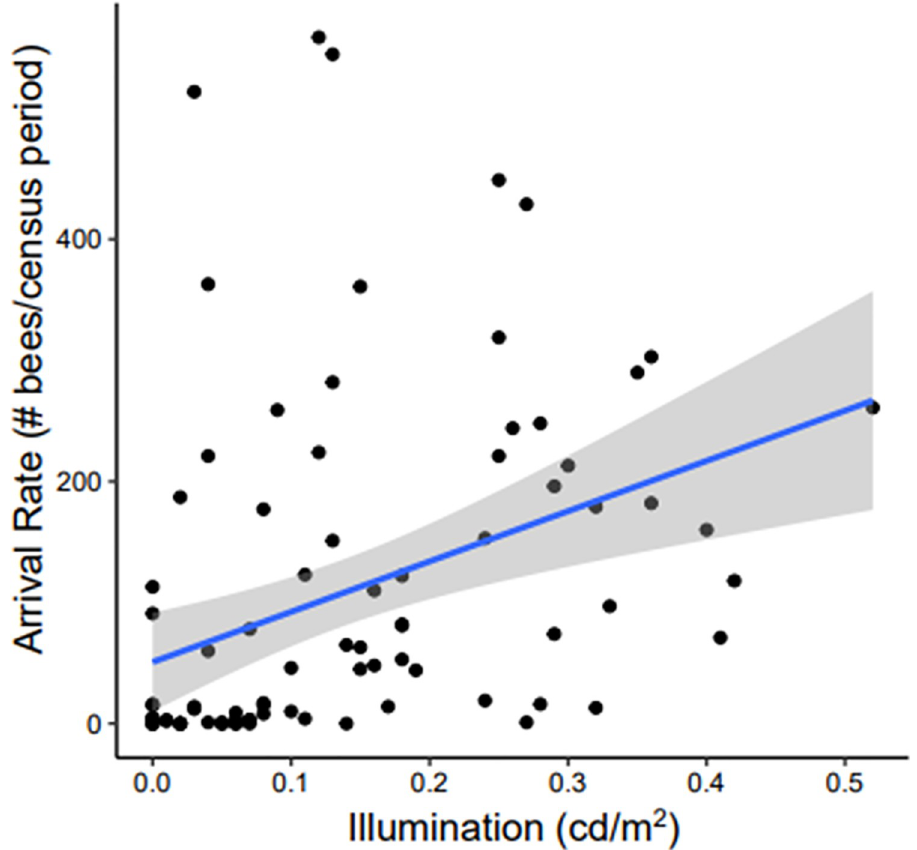
Fig 4. Relationship between nighttime illumination and bee arrival rates. A regression between environmental illumination at night and number of bee arrivals to the nest per census period is shown. Illumination had a significant positive effect on arrivals, such that as illumination increased arrivals also increased ( r were seen even when illumination was recorded as 0 cd/m 2 at the limit of the photometer’s sensitivity. Data shown here were collected exclusively from A . dorsata Colony